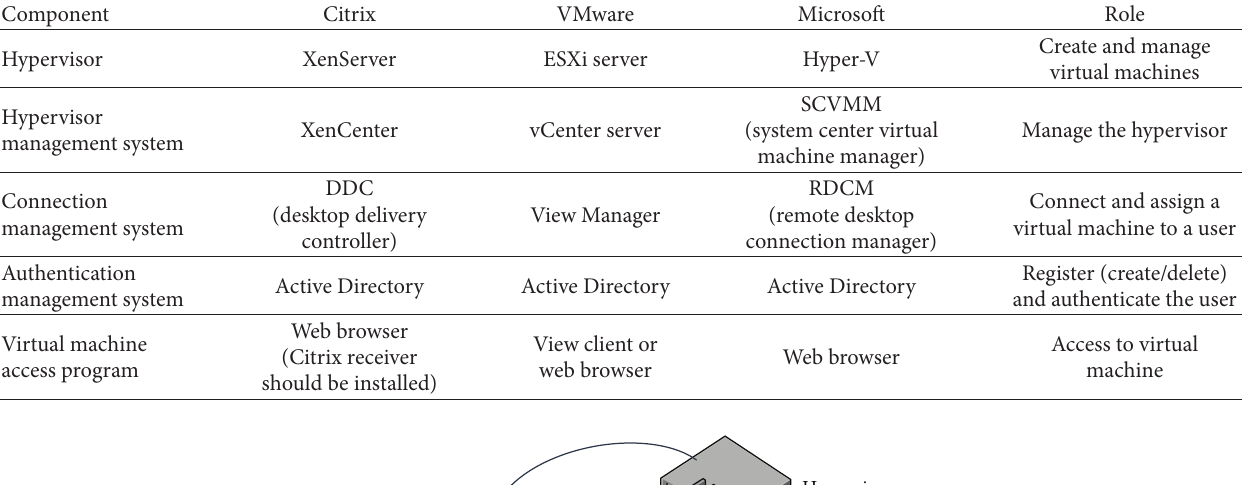
Table 2: VDI components.